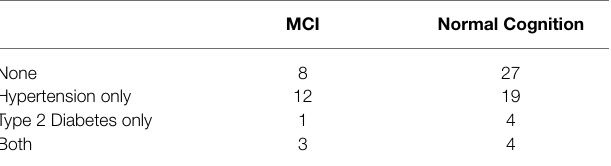
TABLE 2 | Risk factor stratification of the study population by cognition status.